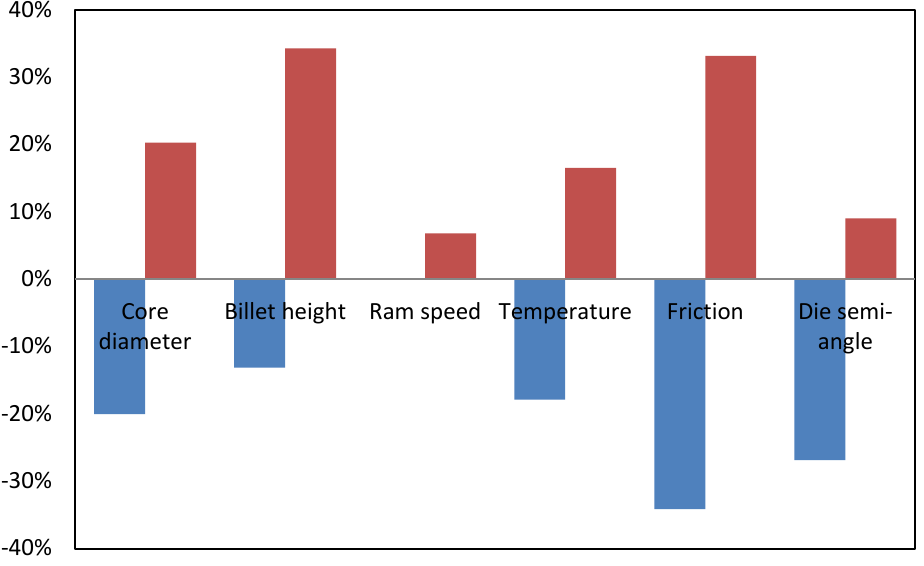
Figure 9. Percentage variation respect the reference value (level 3) of the extrusion force. Table 12. Taguchi’s orthogonal array for extrusion force.